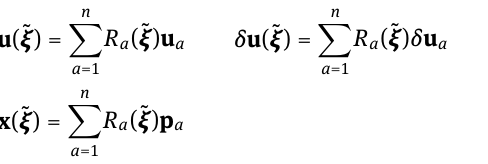
(Fig. 3a). This is equivalent to minimizing the distance